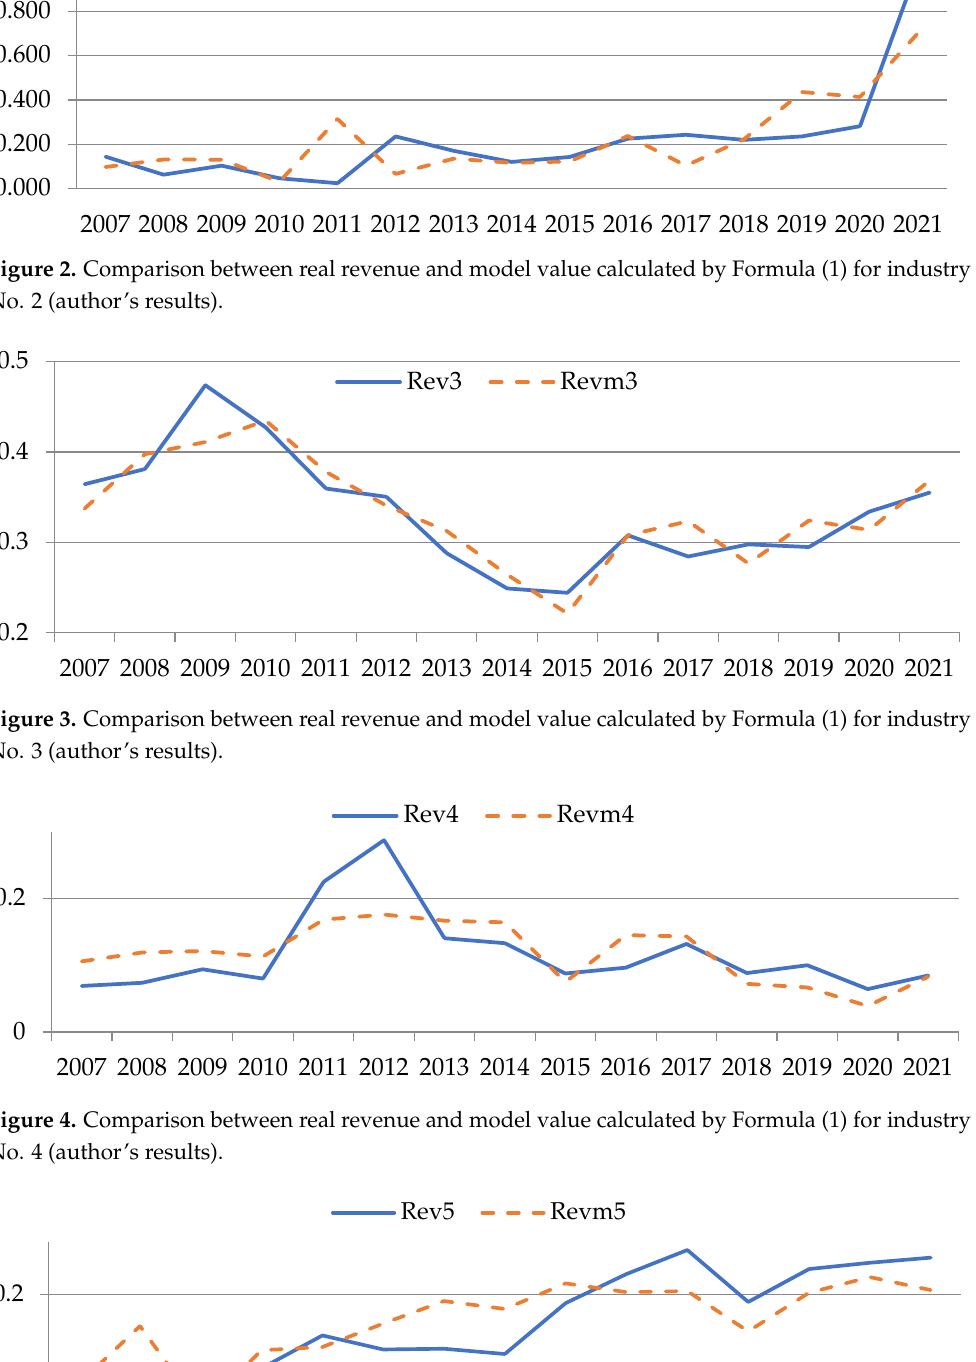
Figure 6. Comparison between real revenue and model value calculated by Formula (1) for industry No. 6, (author’s results). The calculation of the parameters of the indicators change rate 𝜇 (cid:3037) (cid:4666)𝑡(cid:4667) was carried out on the basis of historical data using the Formula (20) 𝜇 (cid:3037) (cid:4666)𝑡(cid:4667) (cid:3404) ∑